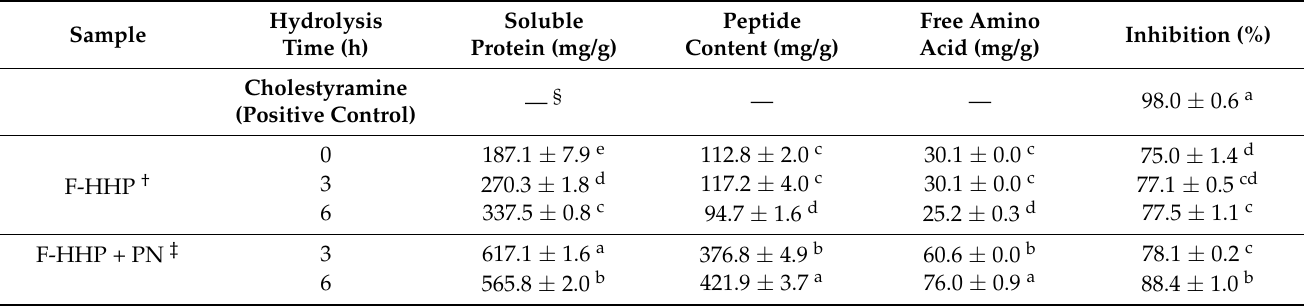
Table 2. Effect of hydrolysis time during HHP on chemical compositions and the inhibition against cholesterol micelle formation from lactic fermentation seabass byproduct hydrolysates